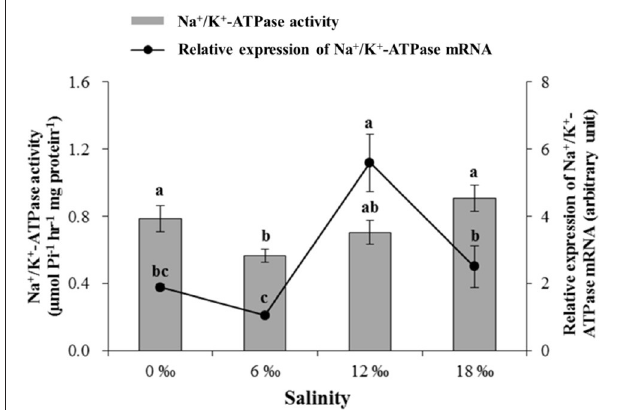
FIGURE 5 | The gill Na + /K + -ATPase activity ( µ mol Pi h − 1 mg protein − 1 ) and its mRNA expression level ( ± SE) in the posterior gills of the female E. sinensis subjected to different salinities for 40 days.